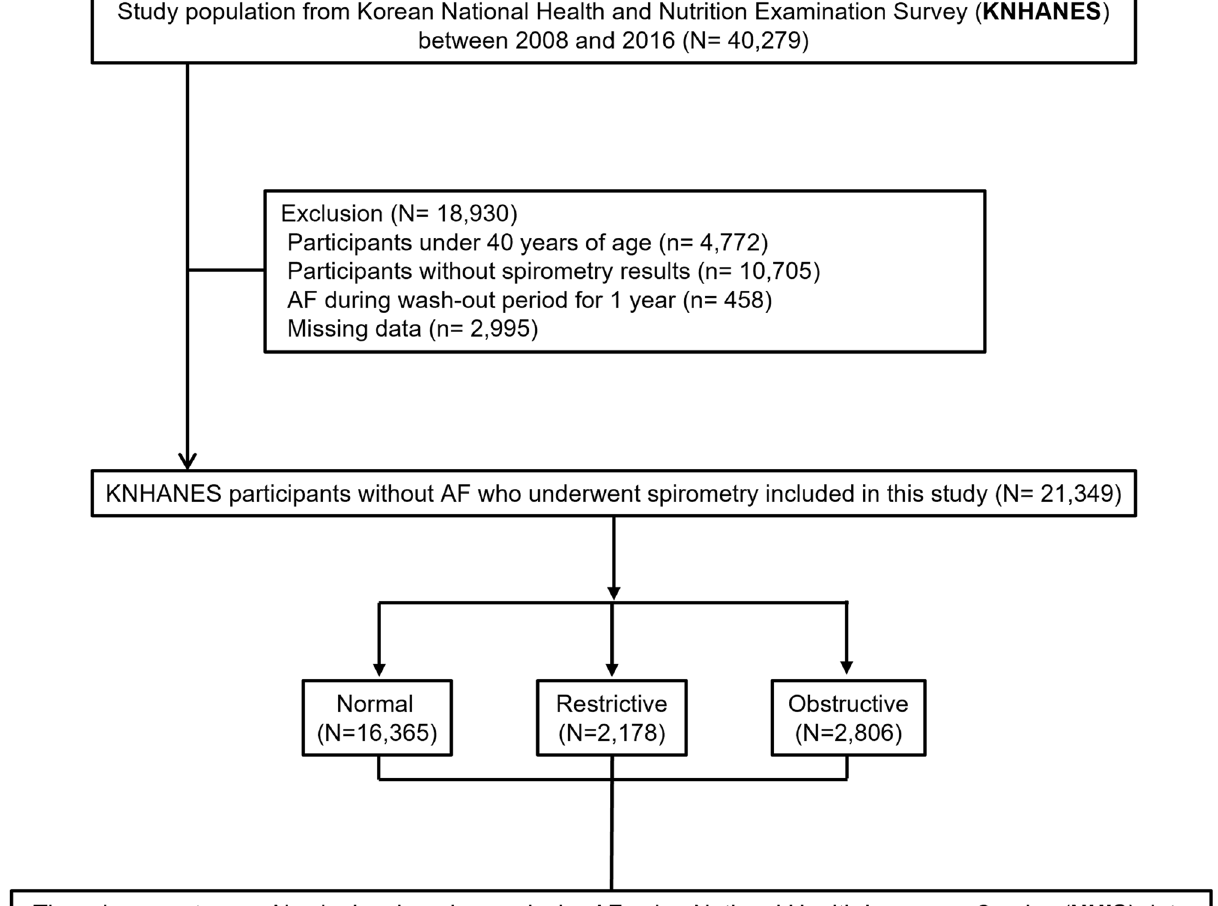
Figure 4. Sample recruitment from the